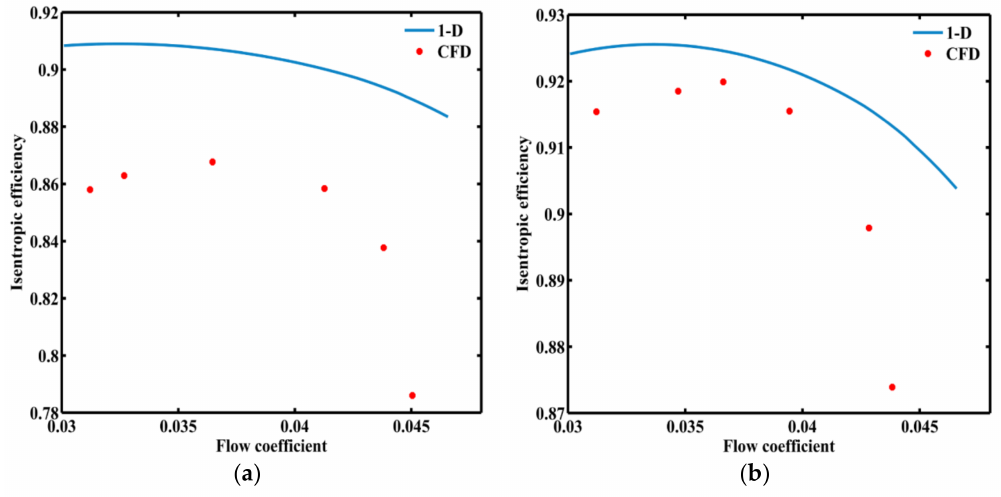
Figure 16. Performance of impeller (1 MWe). ( a ) Impeller efficiency with gap; ( b ) Impeller efficiency without gap.